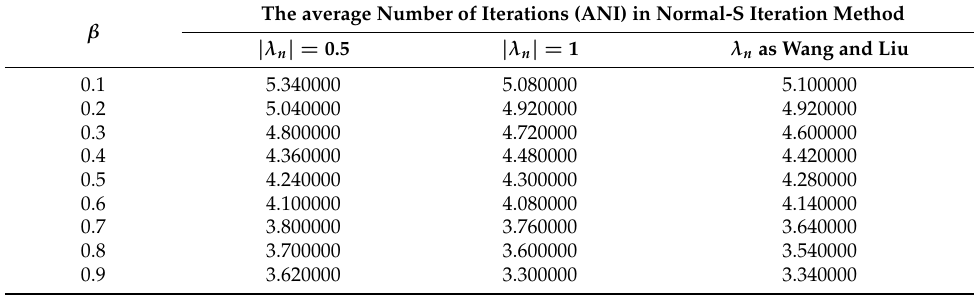
Table 5. The average number of iterations in normal-S iteration